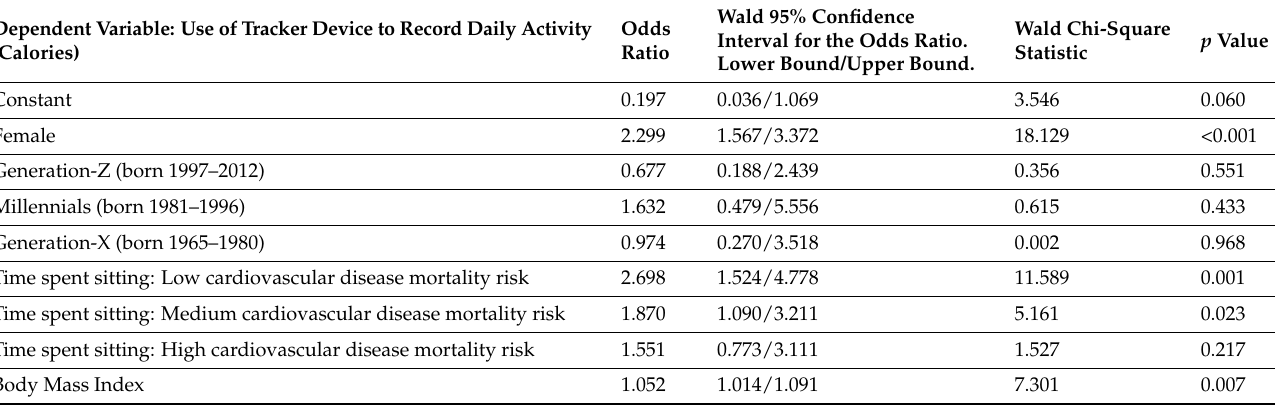
Table 5. Generalized linear model. Parameter